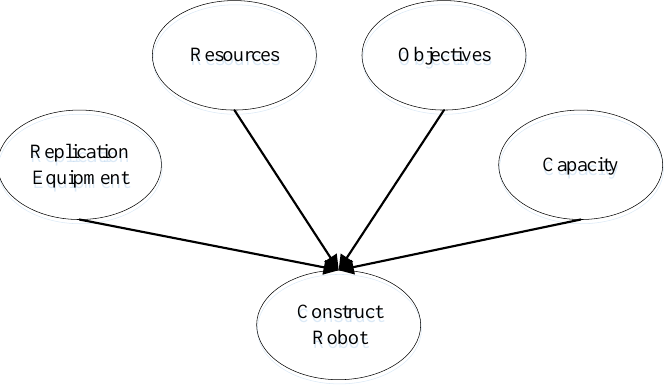
Figure 1. Key decision-making factors for the new robot construction decision.